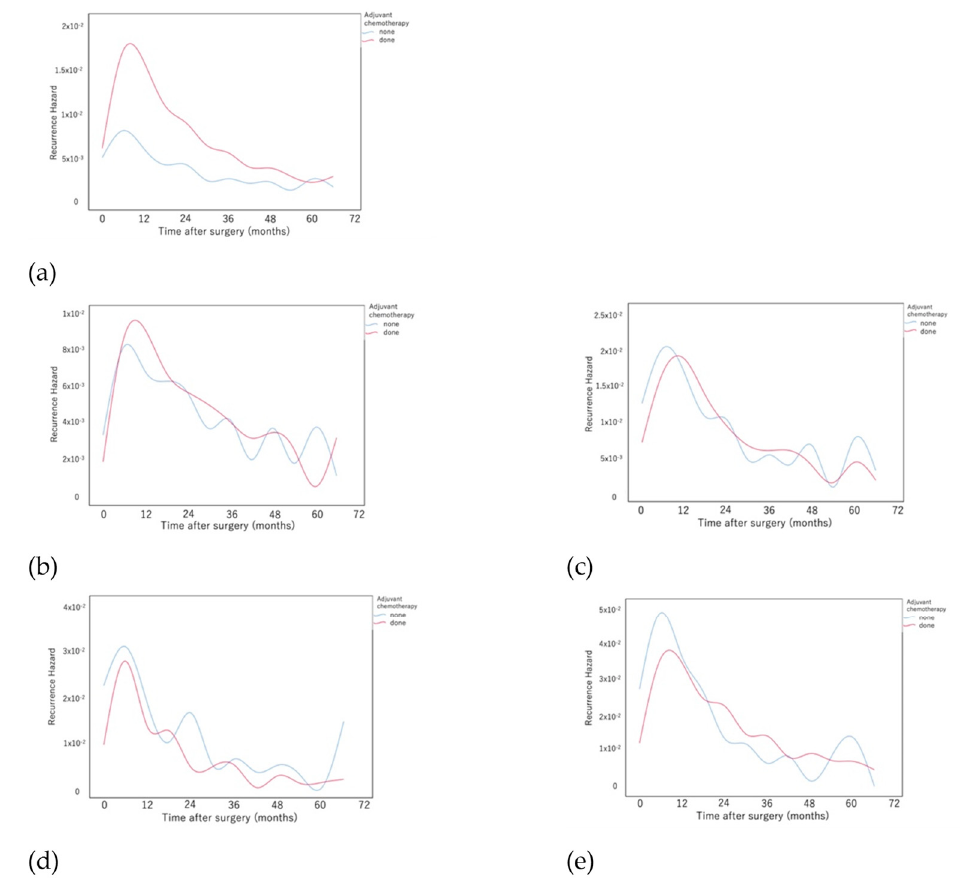
Figure 5. Comparison of the recurrence hazard functions between patients treated with or without adjuvant chemotherapy. ( a ) All patients and patients with ( b ) stage IB, ( c ) stage IIA, ( d ) stage IIB, and ( e ) stage IIIA.